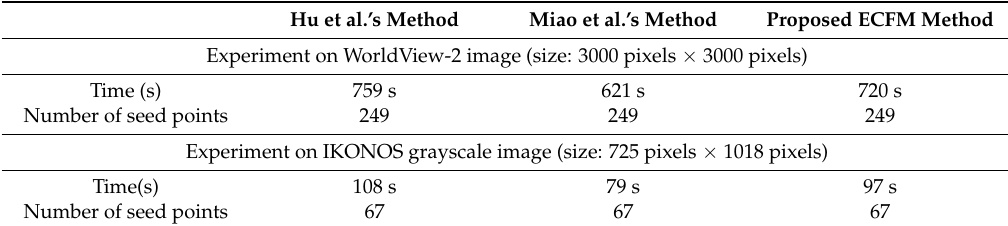
Table 5. Computation Cost of Different Centerline Extraction